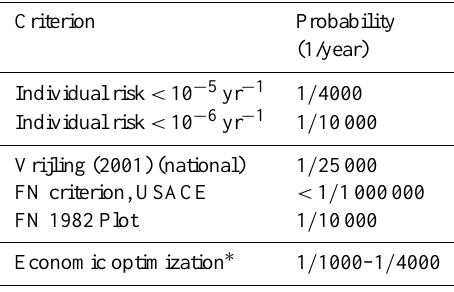
Table 2. Metro bowl protection levels required to meet each pro- posed risk